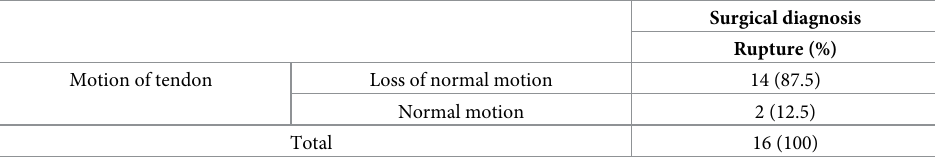
Table 2. Correlation between motion of the tendon on the dynamic study and surgical diagnosis.